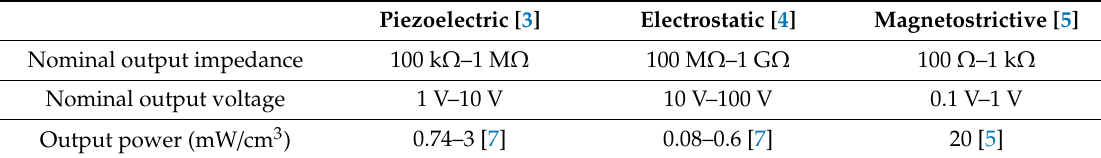
Table 1. Characteristics of vibration energy transducer.